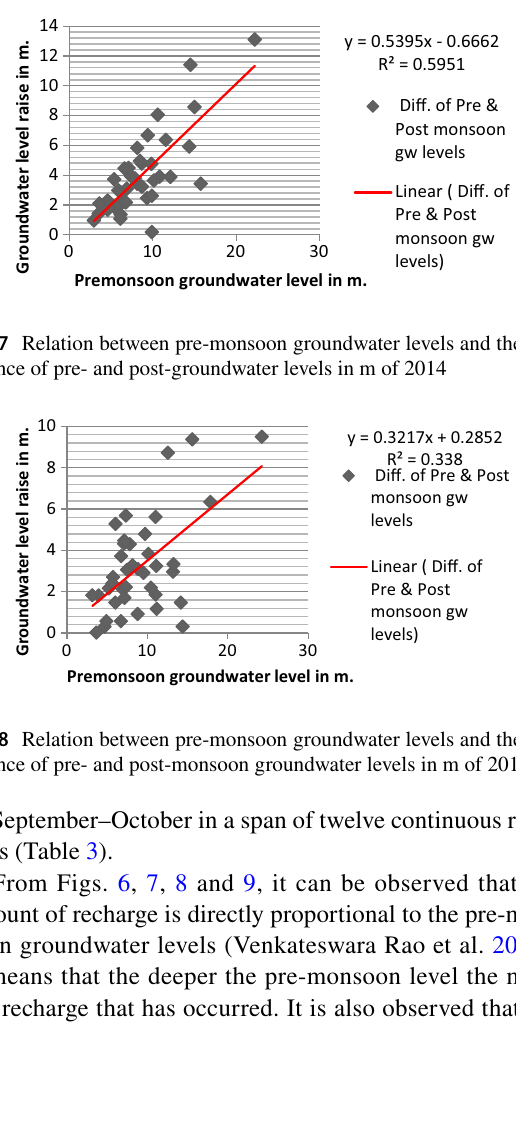
Fig. 6 Relation between pre-monsoon groundwater levels and the dif- ference of pre- and post-groundwater levels in m of 2013